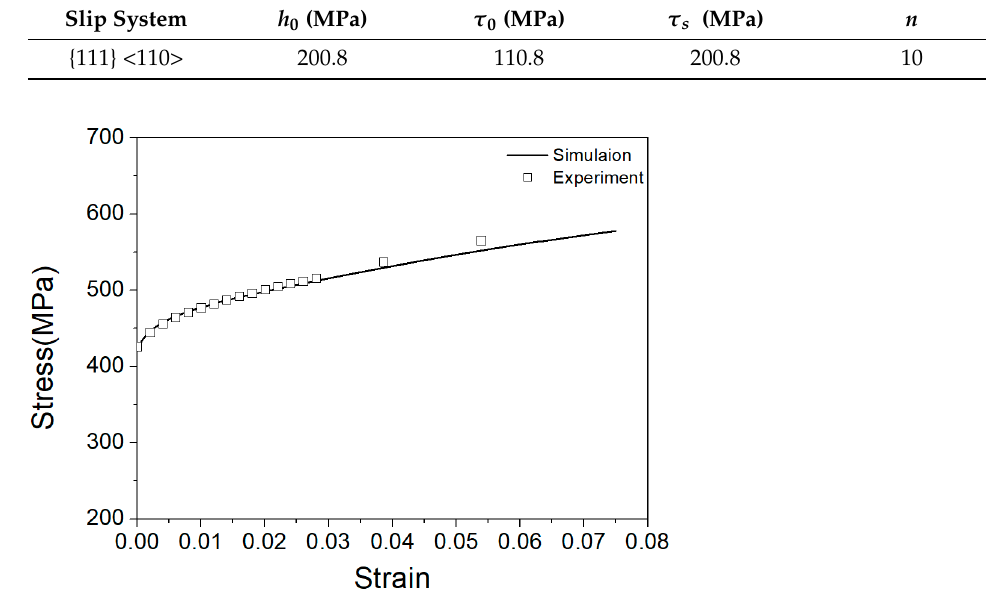
Table 2. Material parameters of Cu-8Al-11Mn alloy (wt.%).